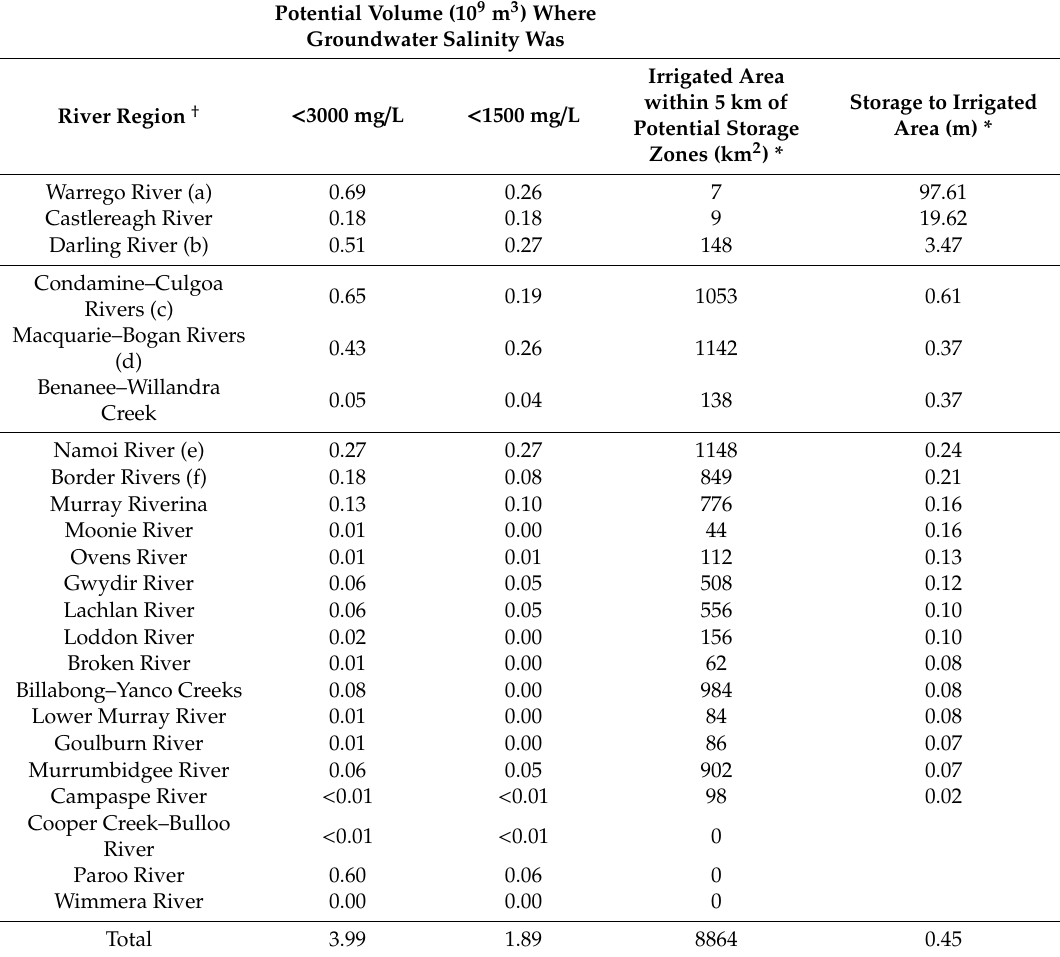
Table 2. Potential aquifer storage volumes considering 100 mm of recharge in water table aquifers within 5 km of watercourses for river regions within the MDB, and area of irrigated agriculture within 5 km of those potential storage